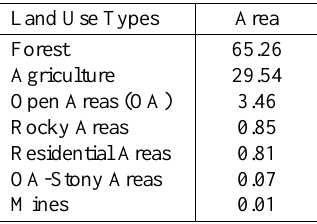
Table 7. Areal distribution (%) of the land use